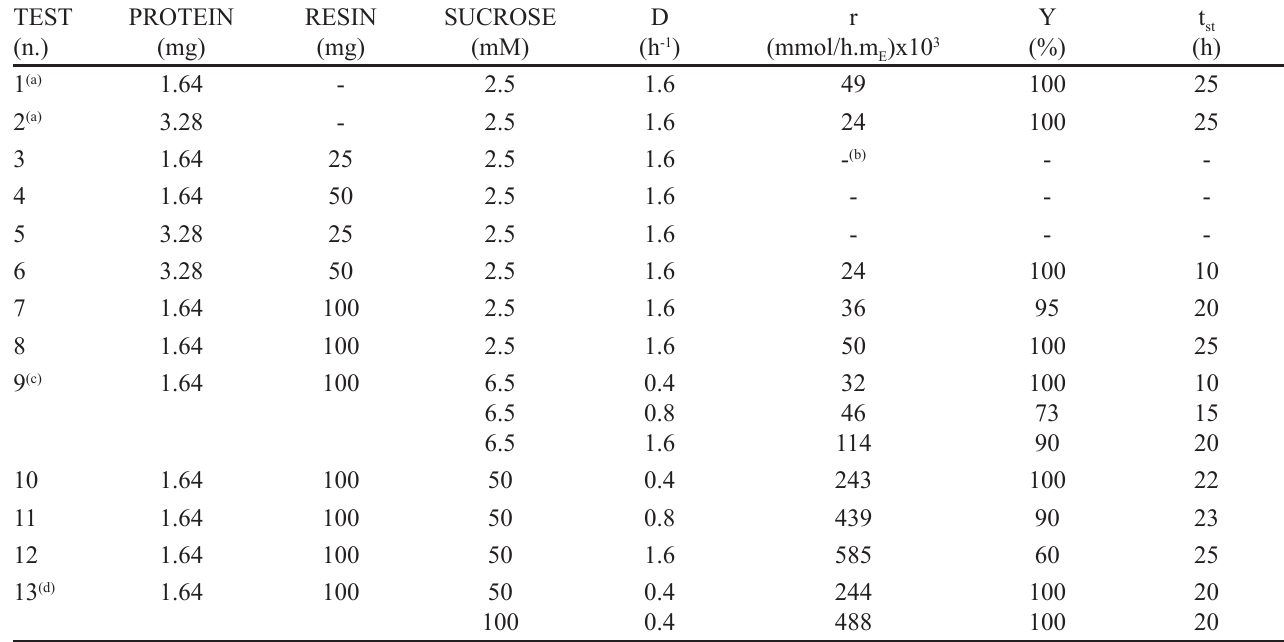
TABLE I - Conditions under which all continuous experiments were conducted and their respective average conversion (Y), specific reaction rate (r) and steady-state duration (t ) attained. The temperature (30 o C) and agitation (100 rpm) were kept constant. In st